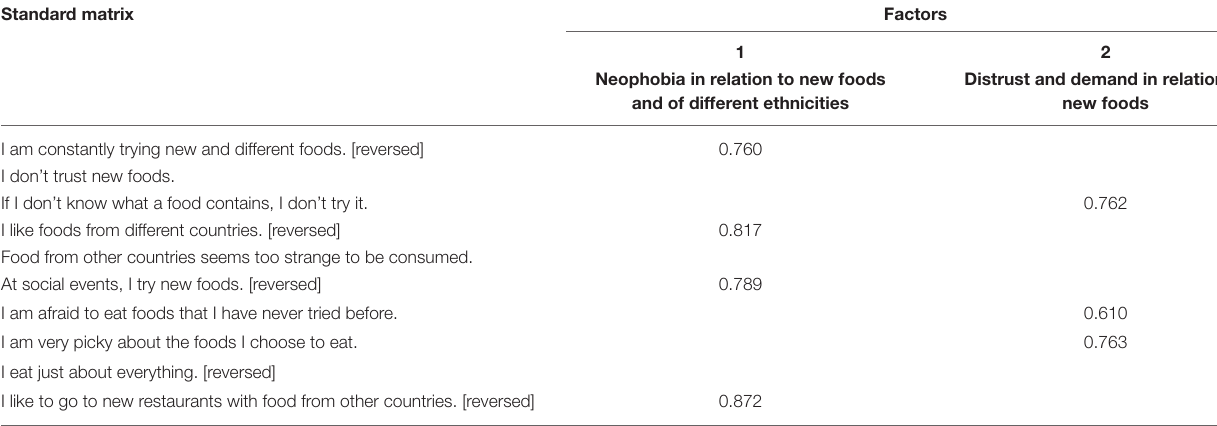
TABLE 5 | Factor analysis of the Pliner and Hobden food neophobia scale (29).